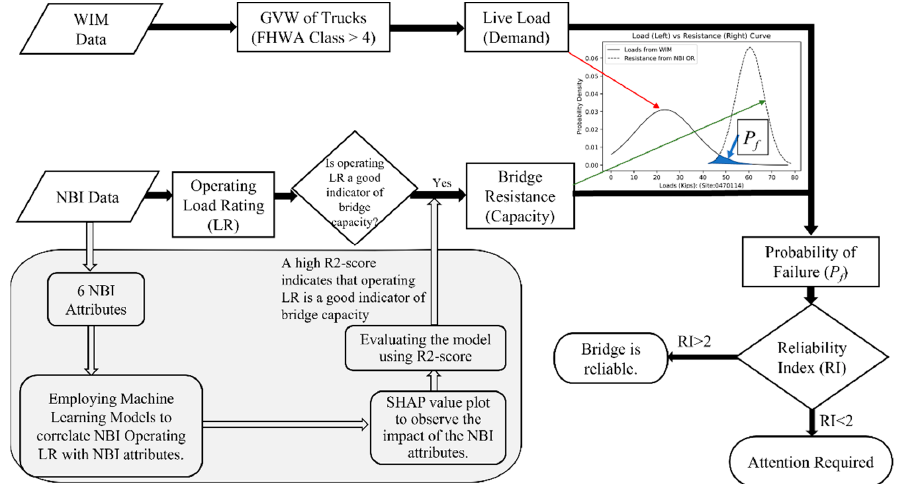
Figure 2. Flow chart showing the WIM data driven reliability assessment.